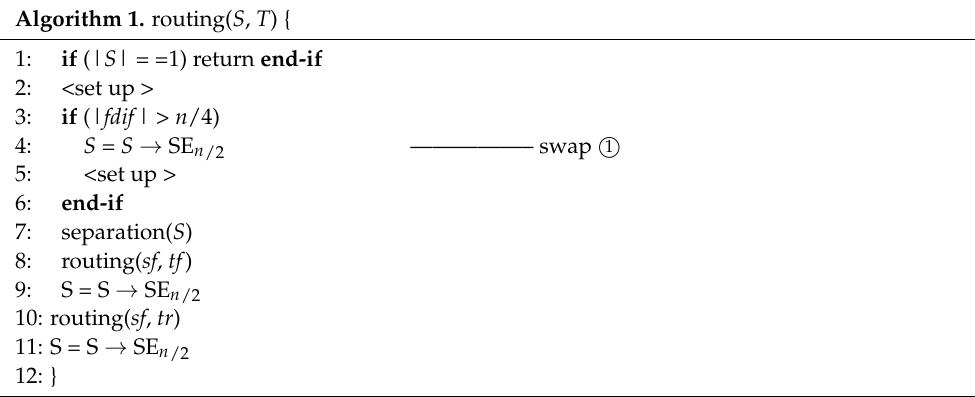
Algorithm 1. routing( S , T ) Algorithm 2. separation( S ) {